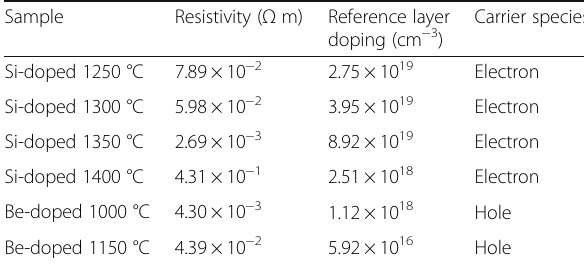
Table 1 The results of Si-doped and Be-doped Au-catalyzed GaAs nanowires electrical measurements, including electrical resistivity that determined by single Au-catalyzed GaAs nanowire devices, reference layer doping concentration, and carrier species are determined by Hall